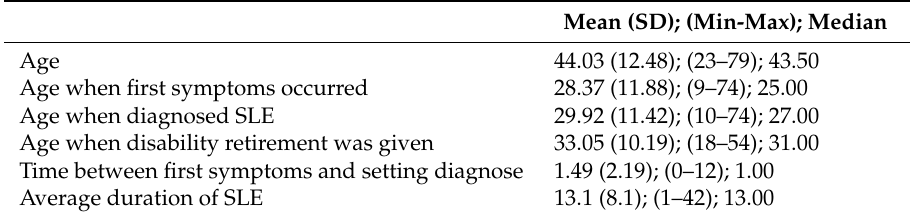
Table 2. Course of SLE disease (Slovakia 2012–2016, n = 67,